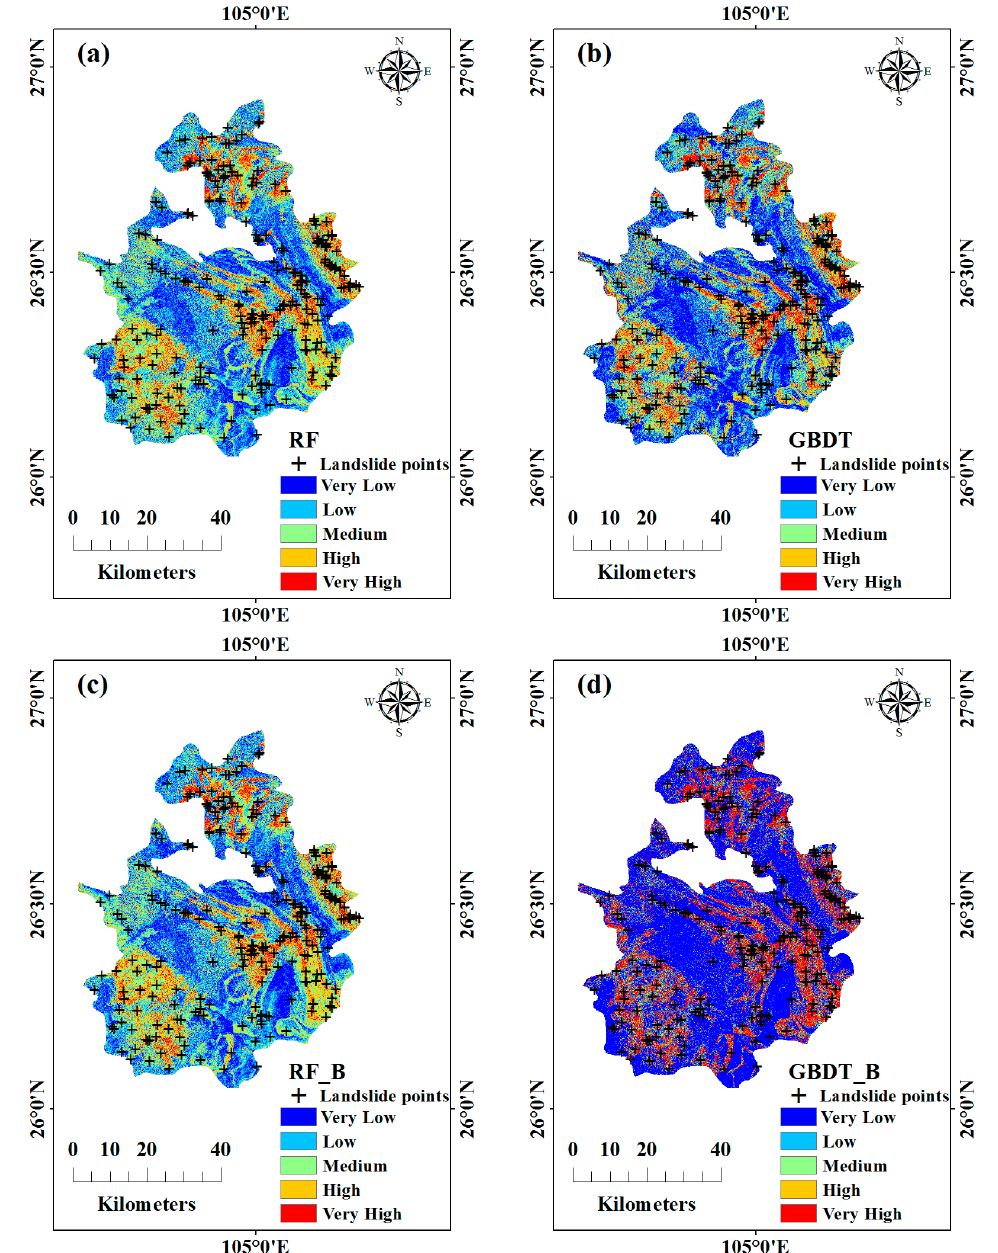
Figure 6. LSMs of Shuicheng County using ( a ) RF, ( b ) GBDT, ( c ) RF_B and ( d ) GBDT_B.